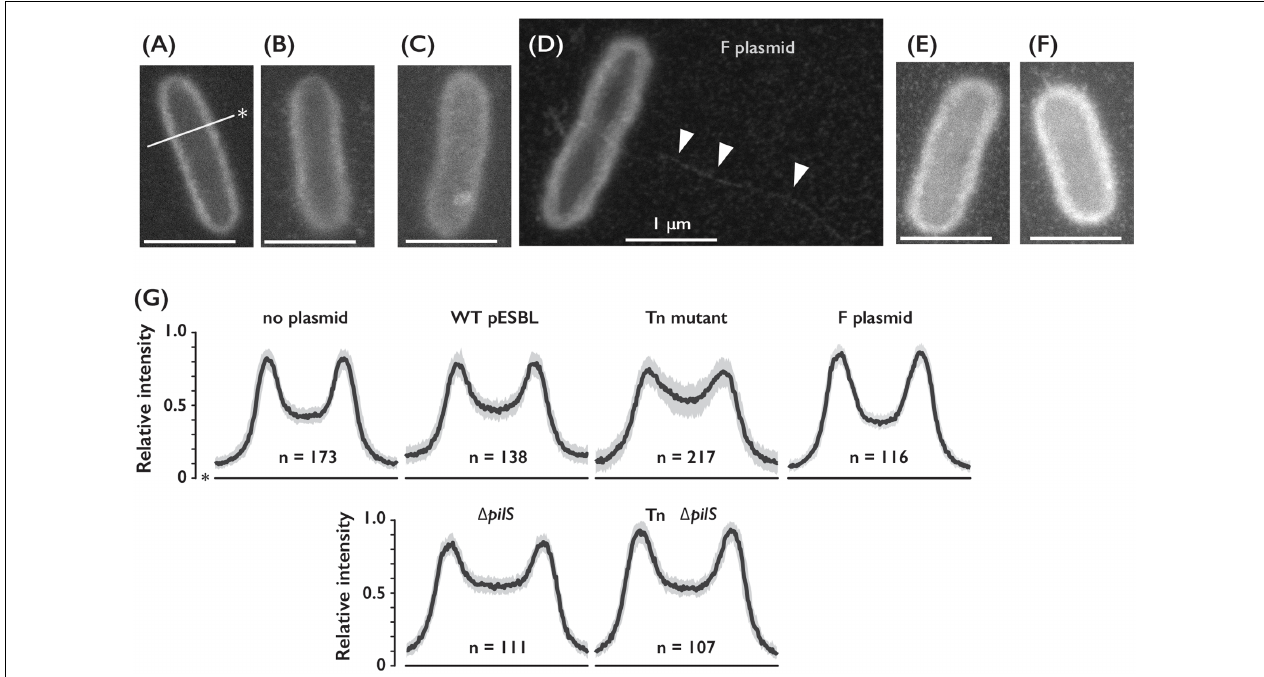
FIGURE 3 | Cell surfaces of E. coli cells harboring different conjugative plasmids. (A–D) Representative ASEM images of E. coli cells without plasmid (A) , or harboring either WT (B) , Tn (C) (cid:49) pilS (E) or Tn (cid:49) pilS mutant (F) of pESBL, and F plasmid (D) . Arrowheads indicate presumable F pilus. Line with an asterisk indicates perpendicular axis for the intensity profile analysis. Bar = 1 µ m. (G) Intensity profile of E. coli cells with or without plasmids as indicated. Among number of cells analyzed shown as n, median was drawn by the solid line and the gray area represents between the first and third